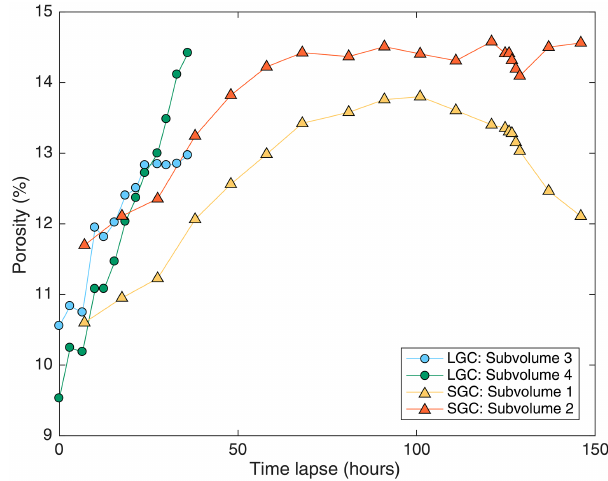
Figure 8. Comparison of porosity evolution in LGC (this study) versus SGC reported by Zhu et al.